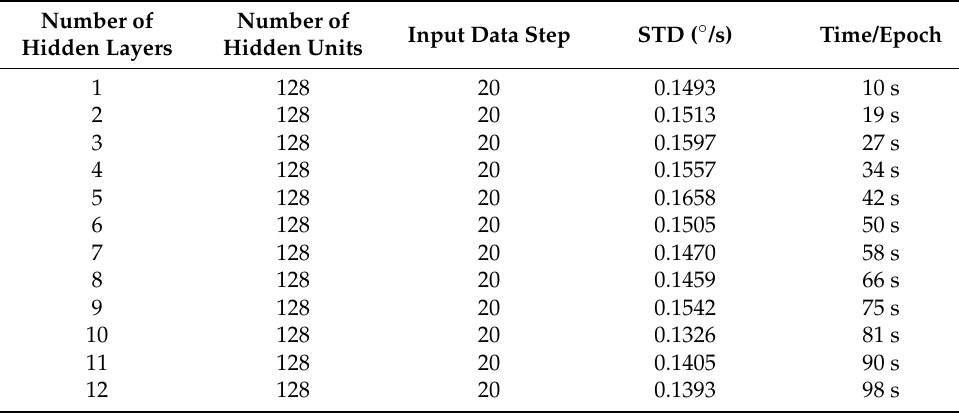
Table 5. Performance with varying values of the number of hidden